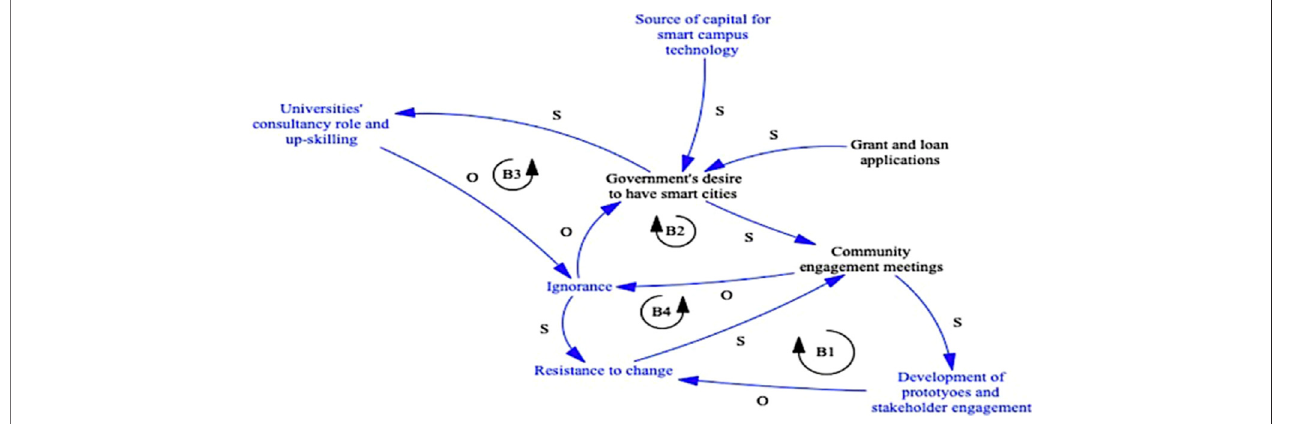
FIGURE 10 | System archetype 5- Alleviating the challenges of developing smart cities in developing countries. Source: Authors.